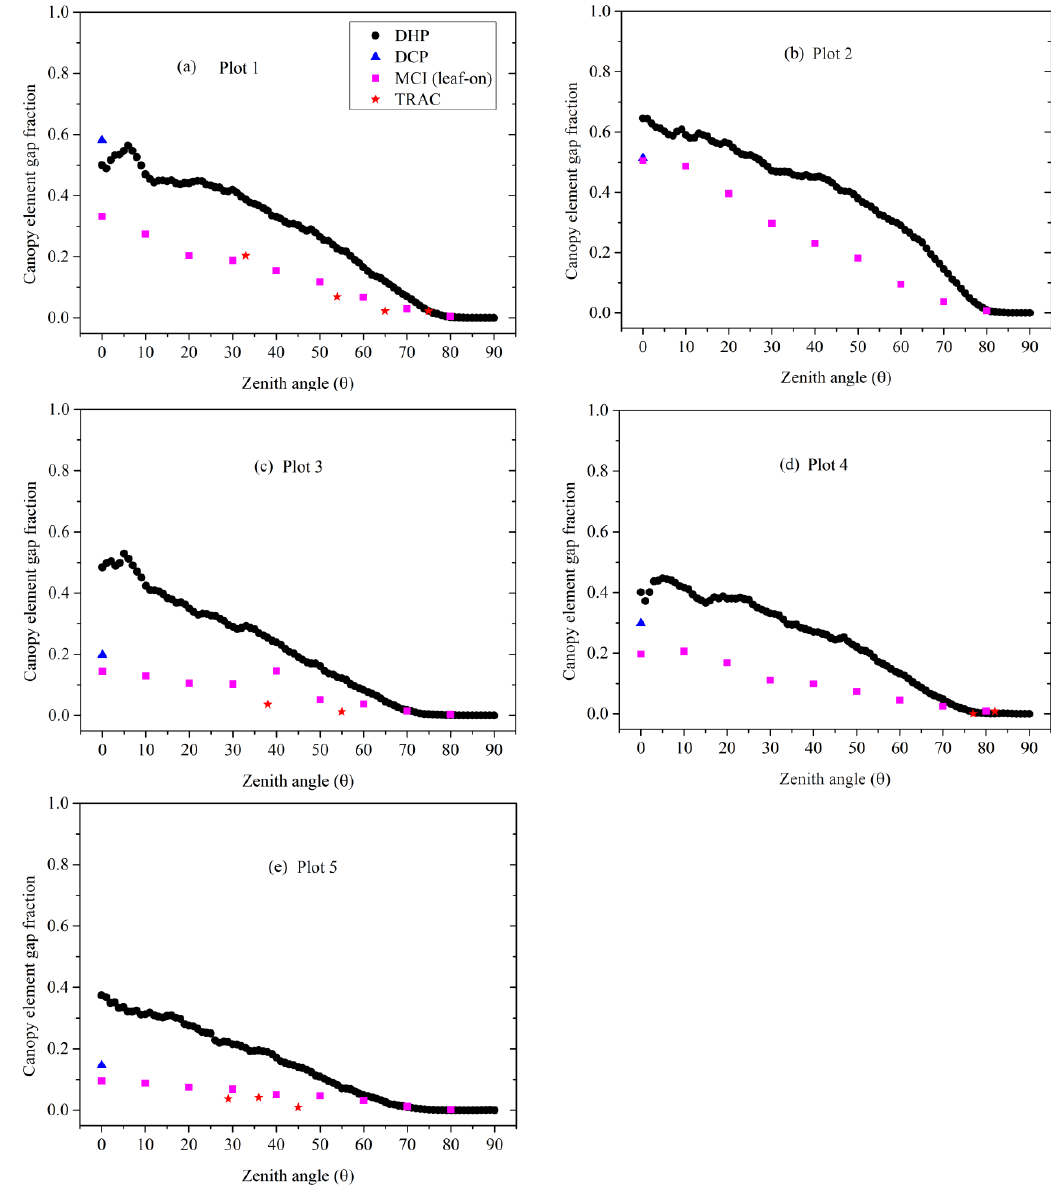
Figure 1. Canopy element gap fraction ( p e ( θ ) ) measurements obtained from DHP, tracing radiation of canopy and architecture (TRAC), MCI, and digital cover photography (DCP) in the five leaf-on plots: ( a ) plot 1, ( b ) plot 2, ( c ) plot 3, ( d ) plot 4, and ( e ) plot 5.